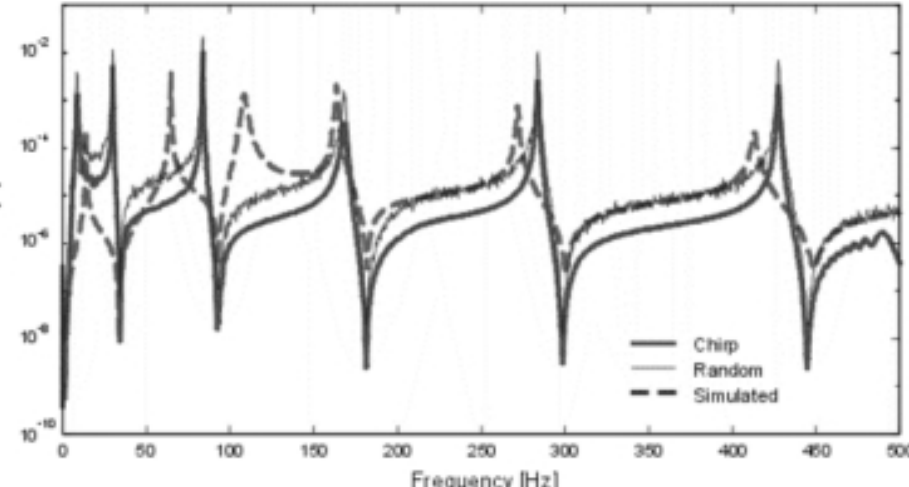
Fig. 11. Input force – voltage mode.